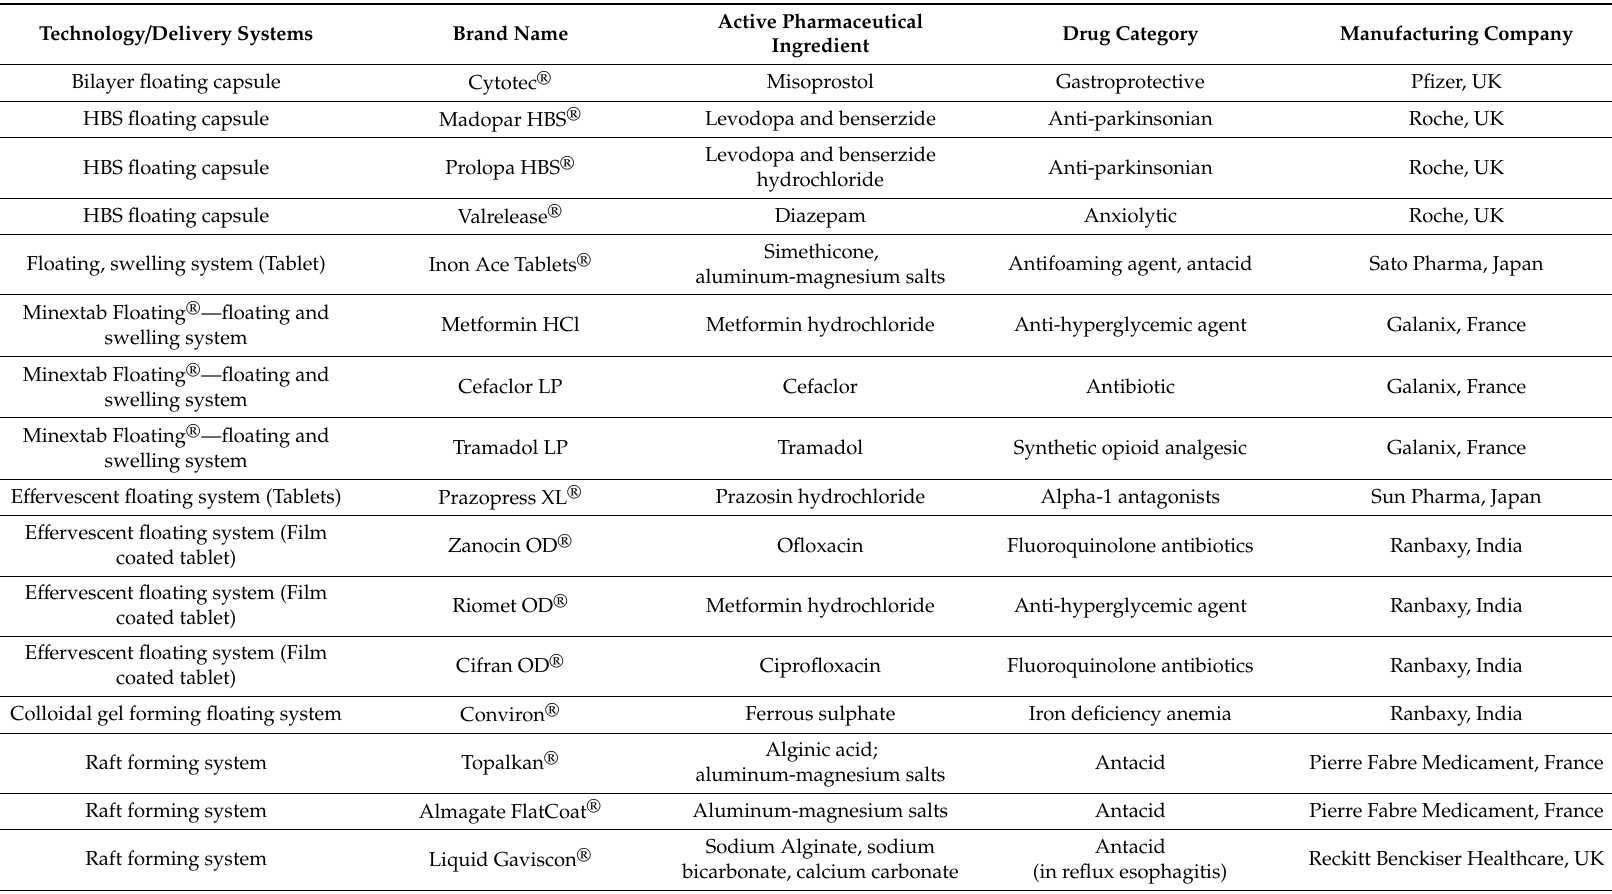
Table 2. Various floating gastroretentive formulations available in the market